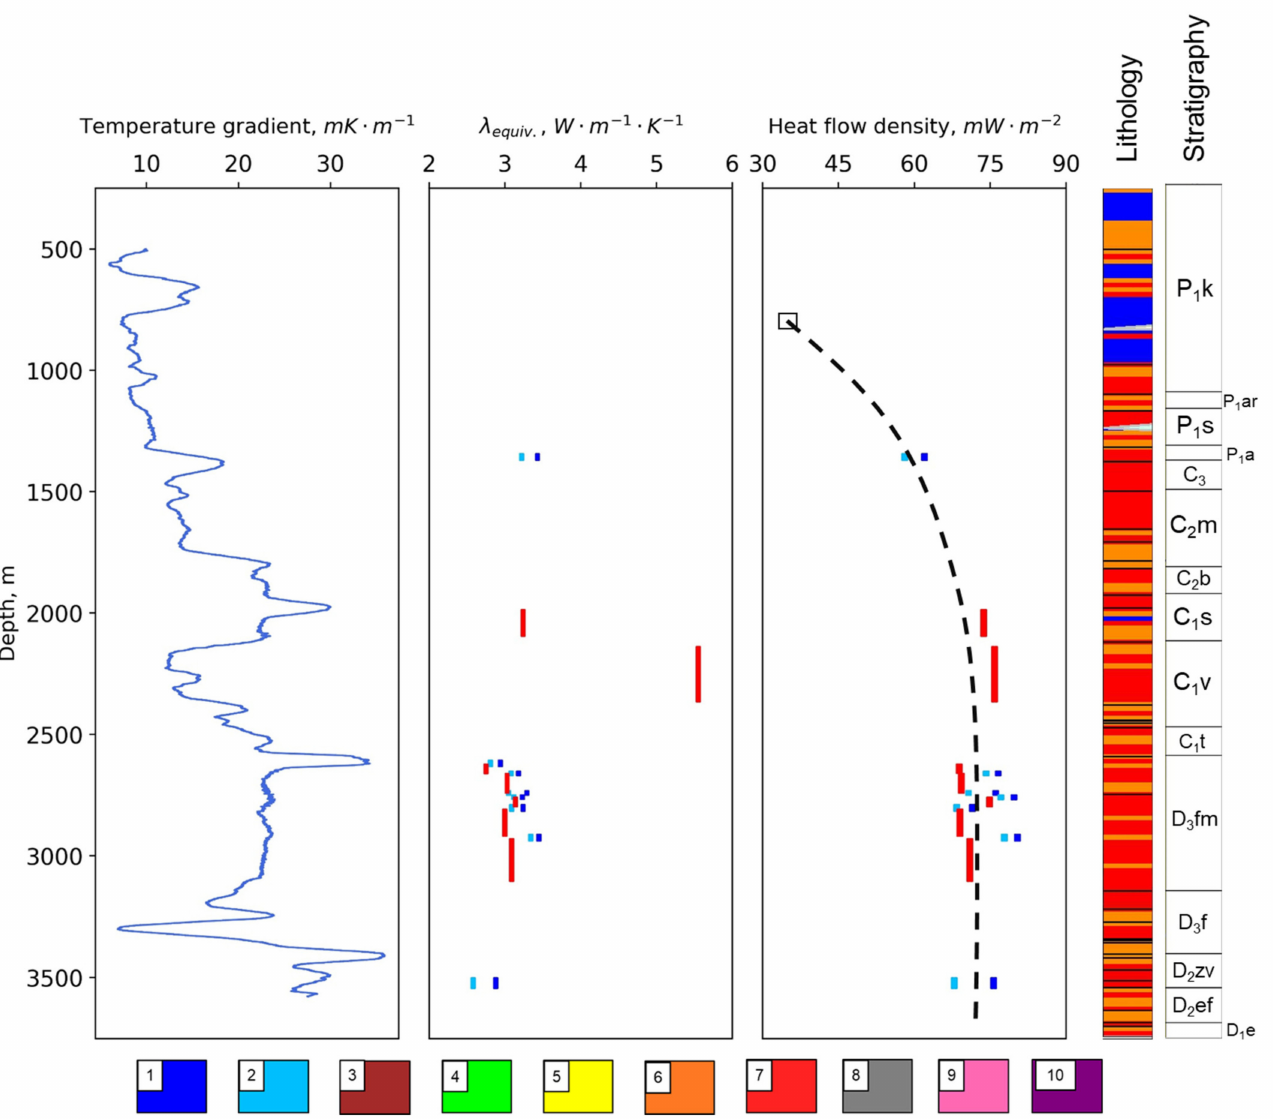
Figure 10. Heat flow density of the investigated depth intervals in comparison to the previously published heat flow density. The blue line ( left panel) presents the temperature gradient (determined within 5 m moving window with a 10 cm step). Light-blue lines ( central panel) present the lower estimate of the equivalent thermal conductivity within coring depth intervals. Blue lines ( central panel) present the upper estimate of the equivalent thermal conductivity within coring depth intervals. Red lines present the average estimates of the equivalent thermal conductivity within the intervals with well-log-based predictions of rock thermal conductivity. Light-blue and blue lines in the ( right panel) of the figure represent the lower and upper estimate of heat flow density within coring depth intervals. Red lines in the ( right panel) represent the average estimate of the heat flow density within the intervals with well-log-based predictions of rock thermal conductivity. The black open square on the ( right panel) represents the data previously published on heat flow density (34.0 mW · m − 2 , see [10,40,41] and Section 4.1) for the area under study. The black vertical line on the ( right panel) presents the trend of the heat flow density (with an average value of 72.6 mW · m − 2 below 2000 m). The lithology legend is given in Figure